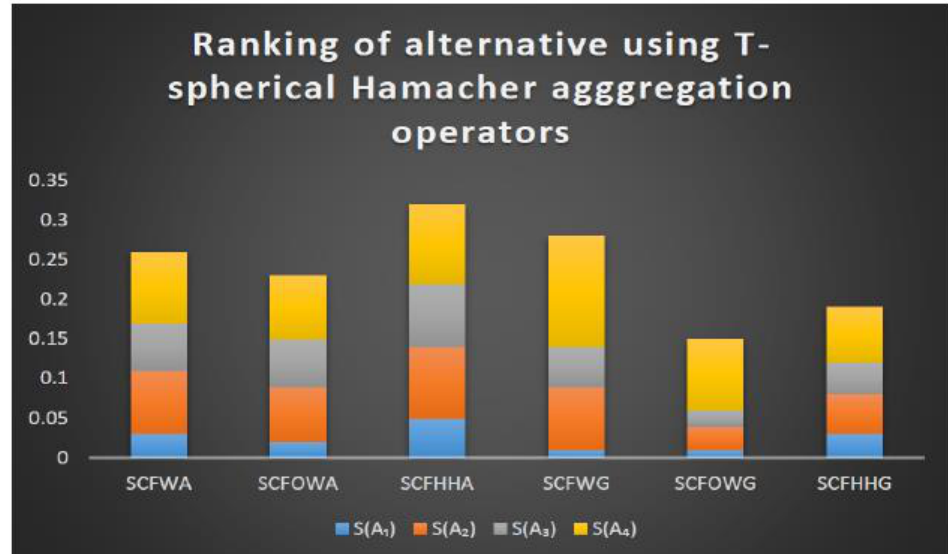
Flow chart of the algorithm. 540